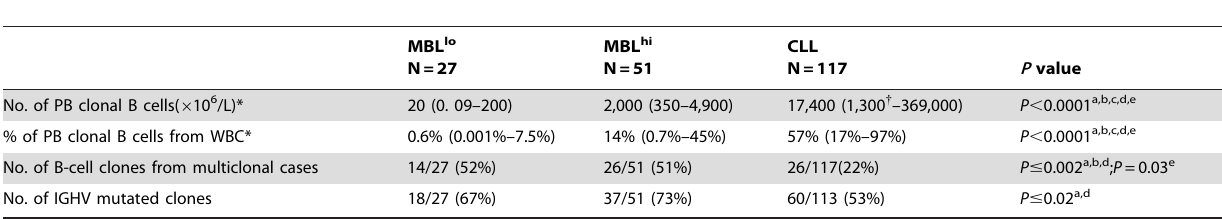
Table 2. Peripheral blood (PB) B-cell counts and BCR features of clonal MBL lo , MBL hi andCLL B cells.